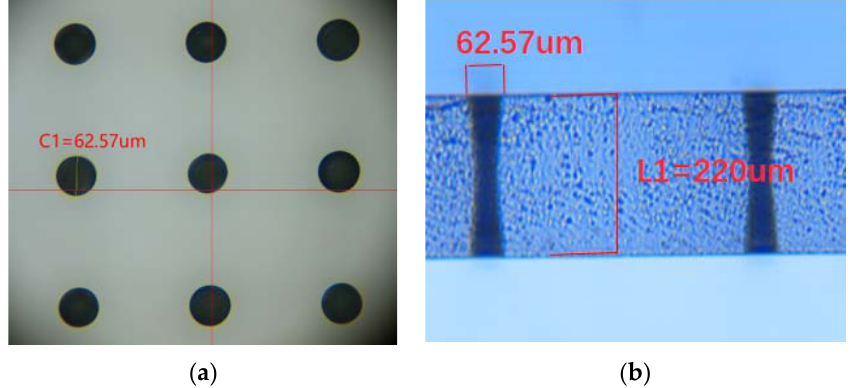
Figure 13. ( a ) Top view of a high-density array of TGVs. ( b ) Cross-sectional image of TGV with the specific size.